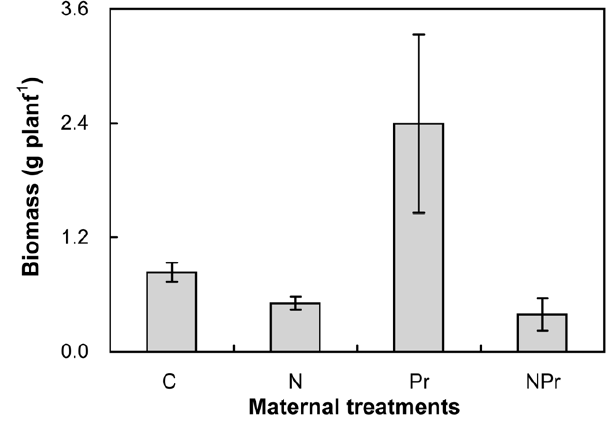
Figure 4. Dependence of seed mass upon seed production (Y= 2 5.84 2 06 X + 0.3278) and germination percentage upon seed mass (Y=441.95X 2 57.04) across all the 4 maternal treatments. Each maternal treatment was marked in the panel. See Figure 1 for abbreviations.